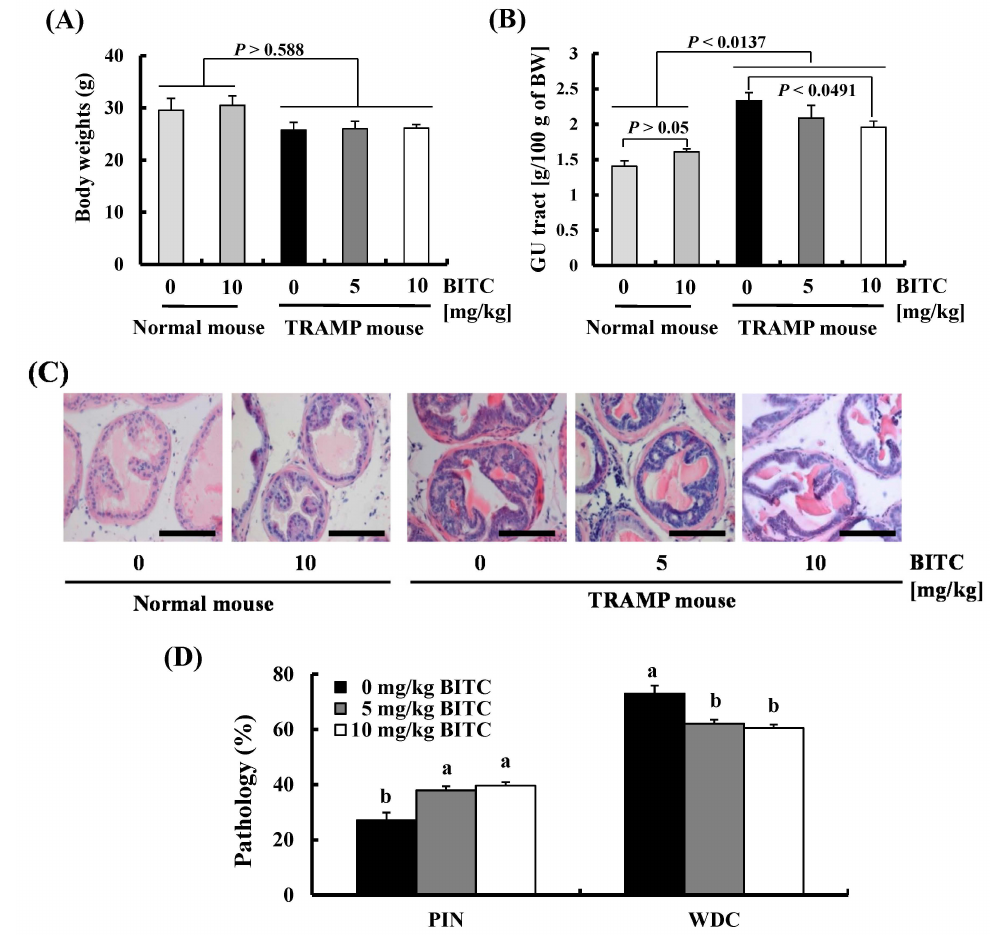
Figure 1. BITC administration delays prostate cancer development in TRAMP mice. Male TRAMP mice and their nontransgenic littermates at five weeks of age were randomly divided into control and BITC-treatment groups and gavage-fed with 0 (vehicle), 5, or 10 mg/kg of BITC every day. At 24 weeks of age, all mice were sacrificed, the GU tracts were excised from the mice and weighed. ( A ) Body weights and ( B ) the GU tract weights; ( C ) Representative photographs of the H and E stained DP from each group ( ˆ 200); ( D ) The incidence of the prostatic intraepithelial neoplasia and adenocarcinoma of the prostate in TRAMP mice. Data represents the mean ˘ SEM ( n = 5). Means without a common letter differ, p < 0.05. GU tract, genitourinary tract; PIN, prostatic intraepithelial neoplasia; WDC, well-differentiated carcinoma. Scale bar, 100 µ